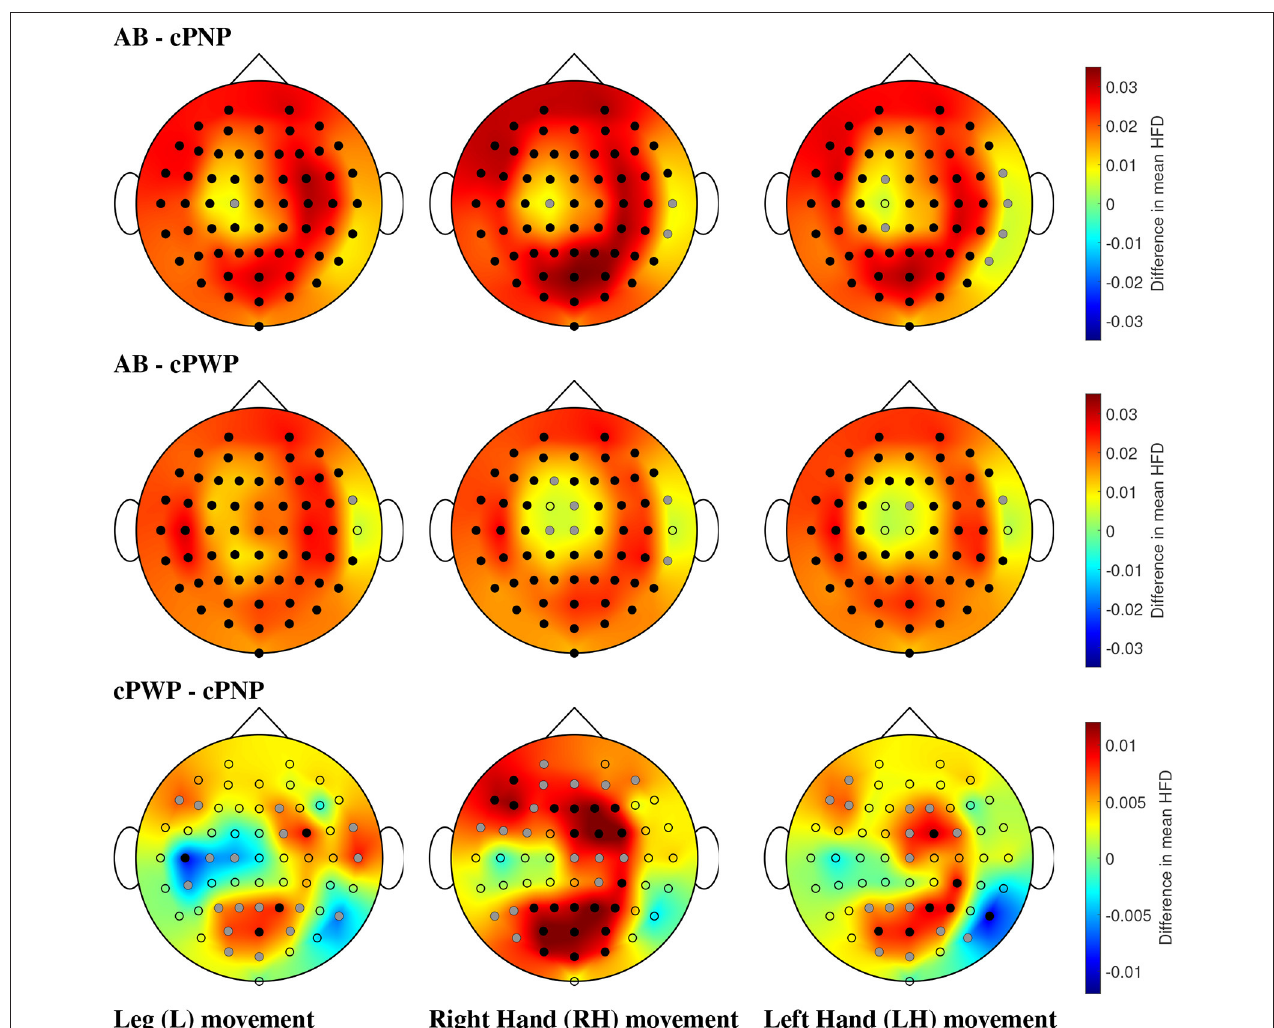
FIGURE 9 | (Dataset 1) Comparison of mean HFD between able-bodied volunteers vs. participants with chronic SCI and no pain (AB - cPNP, top ), AB vs. participants with chronic SCI and with CNP (AB - cPWP, middle ), and cPWP vs. cPNP (bottom) during MI of L, RH, and LH, in the left, center, and right column, respectively, shown as an example for the time window with 2 s offset. Dots represent the locations of all 61 channels; black dots represent electrodes with statistically significant differences in mean HFD and correction for multiple comparisons, and grey dots represent electrodes with statistically significant differences ( p = 0.05) without correction for multiple comparisons. Spatial distributions demonstrate the difference between mean HFD across each pair of groups, where red represents a large positive difference and blue indicates a large negative